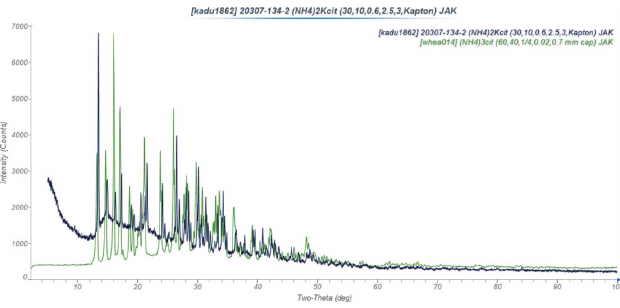
Figure 5 Comparison of the X-ray powder diffraction patterns of diammonium potassium citrate (black) and triammonium citrate